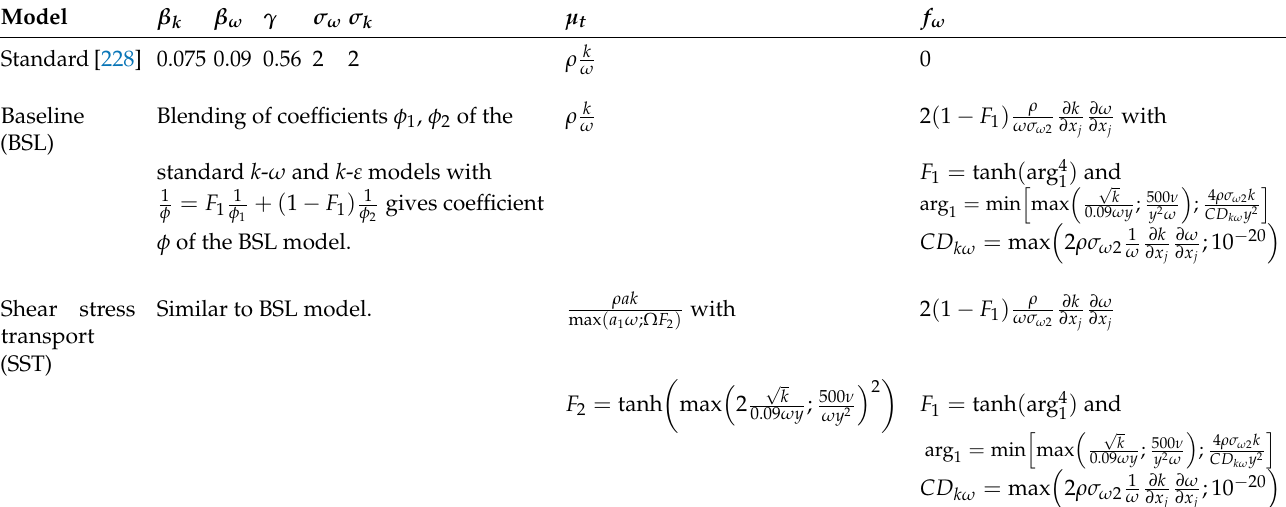
Table 5. Overview of different k - ω turbulence models. The listed expressions refer to (11) and